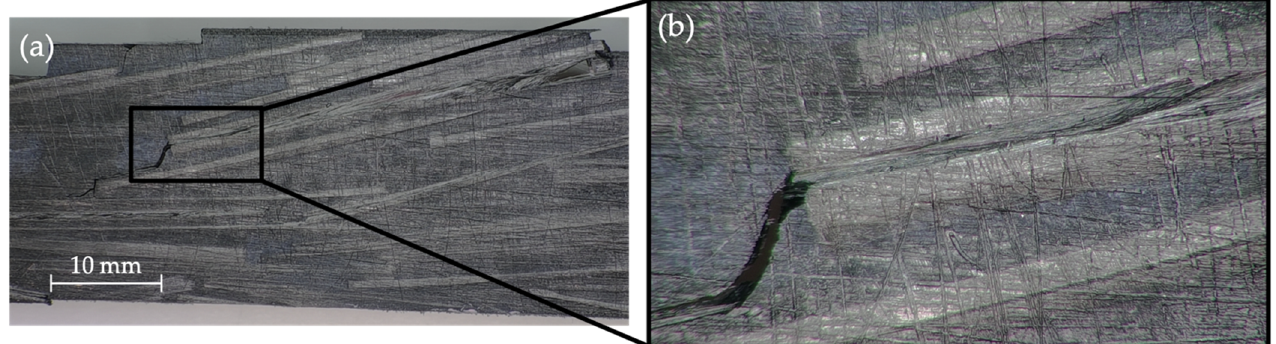
Figure 6. S-N curves obtained after tension–tension fatigue testing. ( a ) PA11 composites; ( b ) PA12 composites.